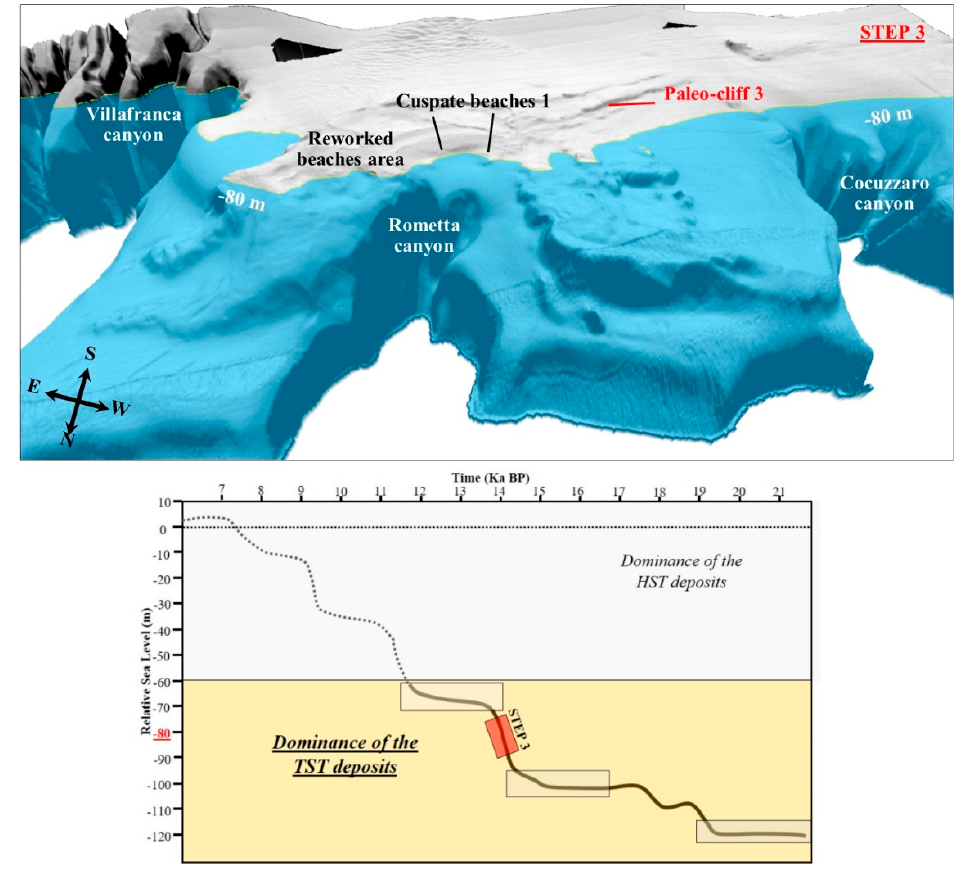
Figure 9. On the basis of a 3D bathymetric map, the reconstruction of the geomorphological evolution of past coastal systems of the area between the Cocuzzaro and Rometta canyons, simulating a sea level of − 80 m.